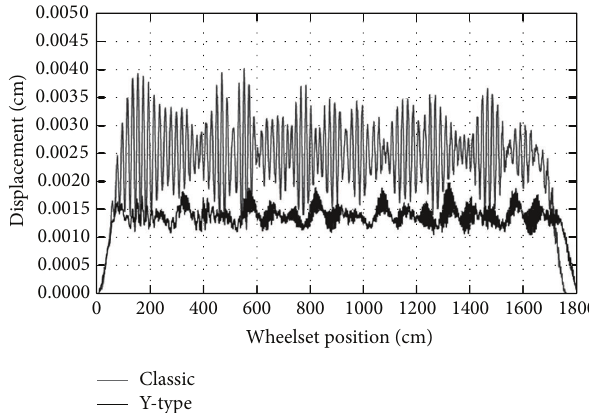
Figure 15: Vertical displacements of rails registered 120cm in front of the contact points of the buggy for classic and “Y” - type track at the speed 40 m/s [12].